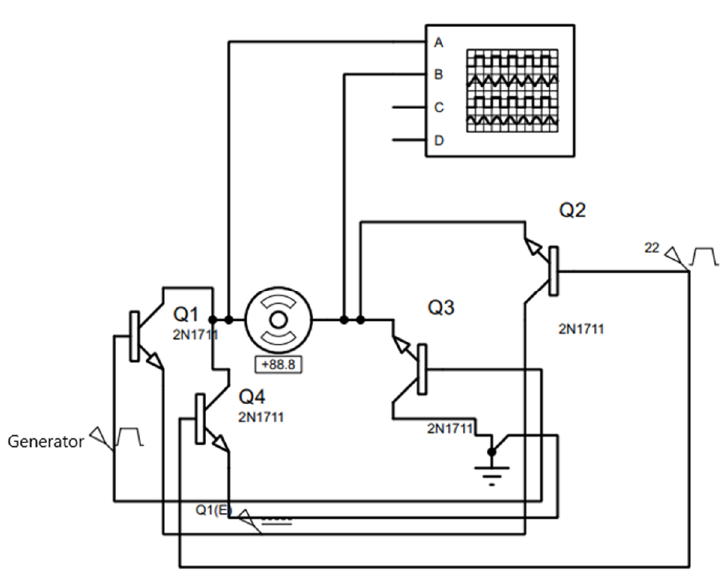
Figure 14. Diagram of the part of the circuit responsible for avoiding short circuits in the lines, (gen- erator and 22 are pulses generated and sent by the microcontroller while Q1(E) is the voltage